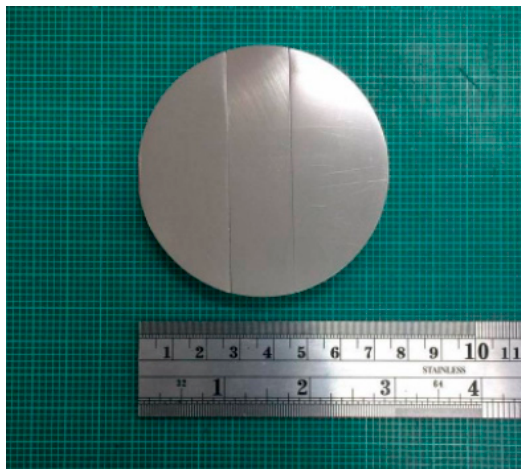
Figure 1. The appearance of the assembled Zr-based target with dimensions of 76 mm in diameter and 8 mm in thickness for the sputtering process. Table 1. Chemical composition of Mg-based bulk metallic glass (BMG) and Mg-based bulk metallic glass composite (BMGC) analyzed by EDS. Material (at.%)